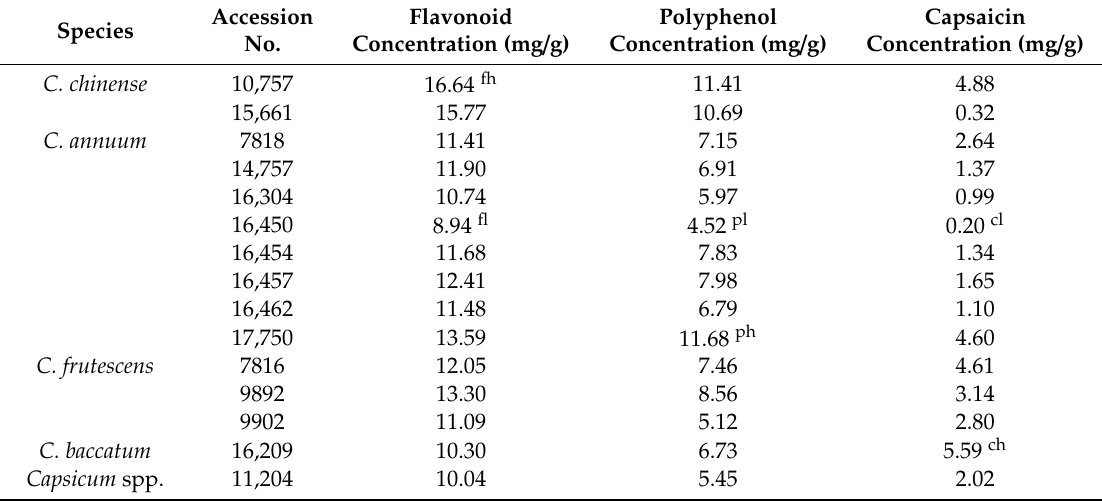
Table 7. Flavonoid, polyphenol and capsaicin concentrations in seven accessions representing four species of Capsicum in the CATIE